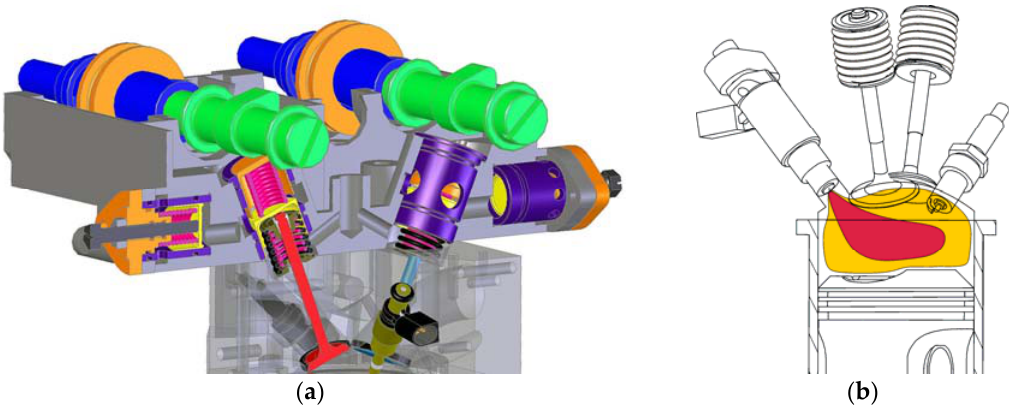
Figure 1. Cross ‐ section of the valvetrain ( a ) and combustion system with mixture stratification idea ( b ).